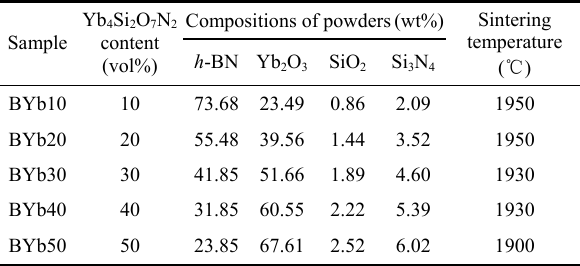
Table 1 Initial compositions of powders and sintering temperatures for h -BN/Yb 4 Si 2 O 7 N 2